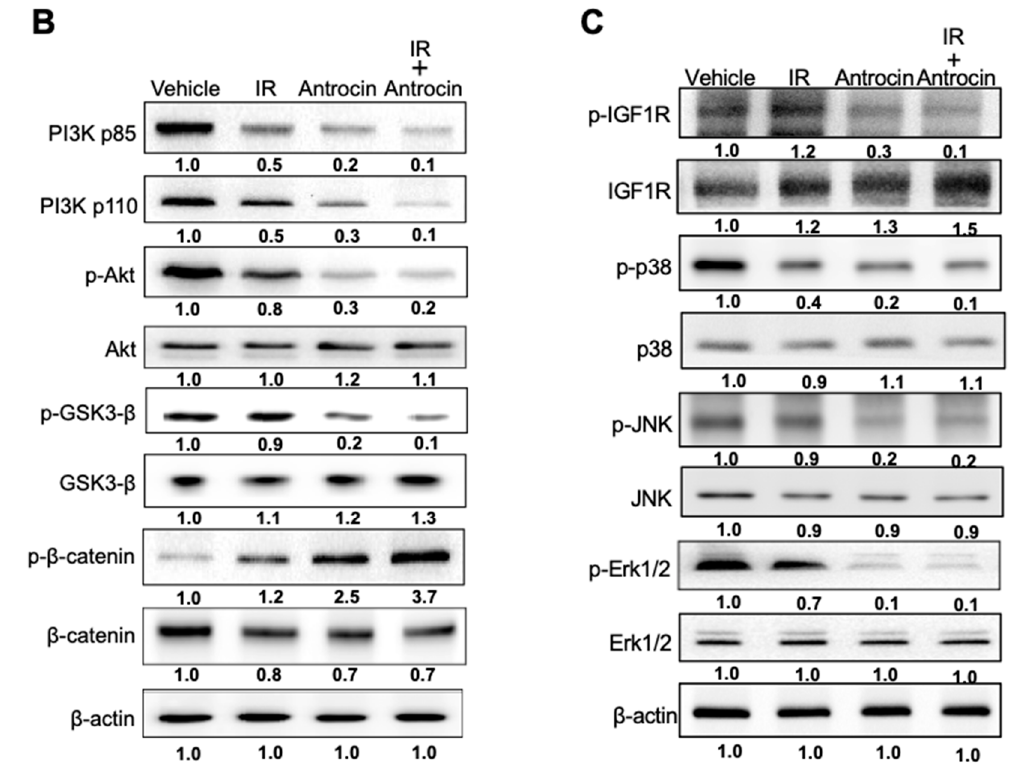
Figure 5. Antrocin inhibits the PI3K/AKT and MAPK signaling pathways and phosphorylation of IGF-1R. PC3-KD cells were treated with IR (2 Gy), antrocin (100 µ M), or IR plus antrocin, followed by incubation for 48 h. ( A ) The represented gene network was identified by ingenuity pathway analysis. The color of each line indicates the regulation of gene expression. ( B ) Cell lysates were harvested and subjected to Western blot analysis using antibodies against p85, p110, p-AKT, AKT, GSK3- β , p-GSK3- β , p- β -catenin, and β -catenin, and ( C ) antibodies against IGF-1R, p38, JNK, Erk1/2, and their respective phosphorylated forms. The data represent one of three independent experiments. β -actin was used as a loading control. The expression level of each protein was quantified by the signal intensity and normalized with each vehicle untreated group. The relative level of each protein expression was indicated at the bottom of each lane.